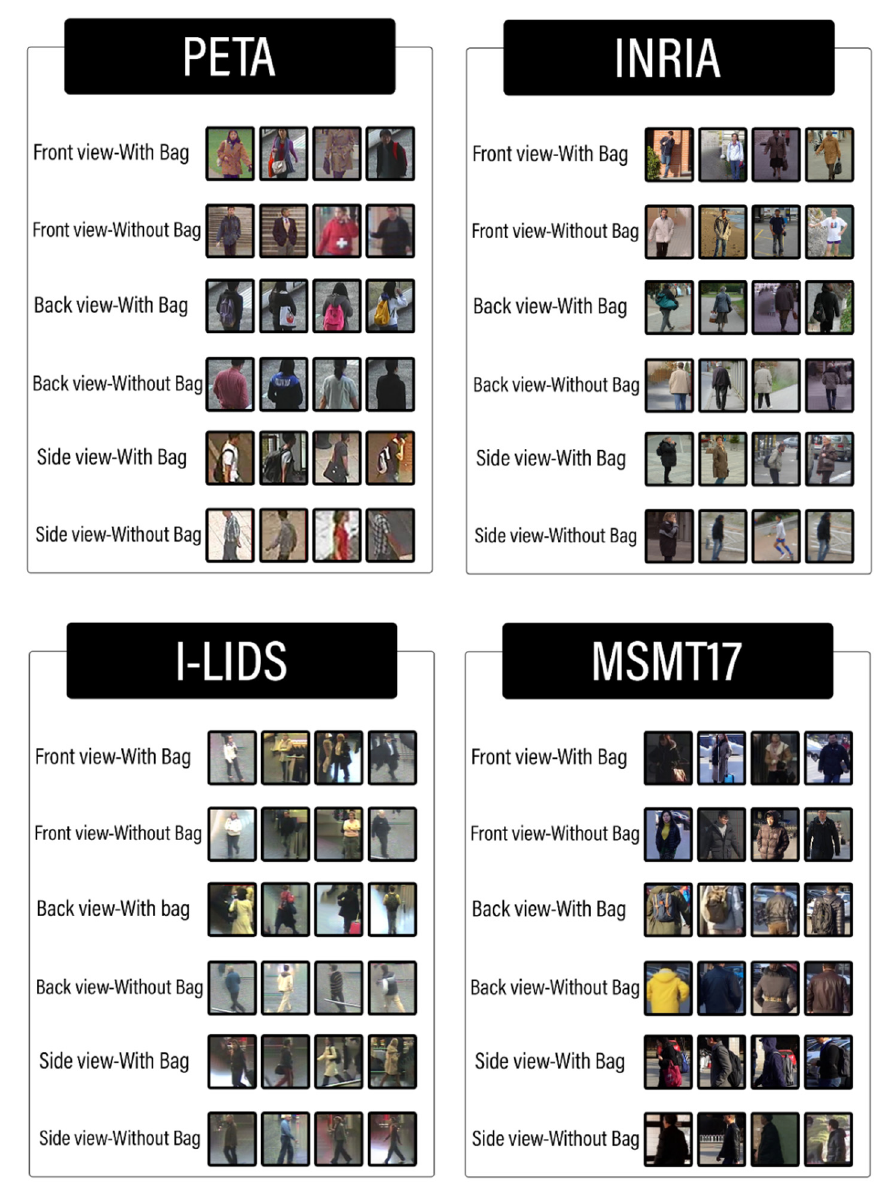
Figure 4. Images from the PETA, INRA, ILIDS, and MSMT17 databases are used as examples from each dataset. This figure demonstrates how one's status might vary throughout the six classes.